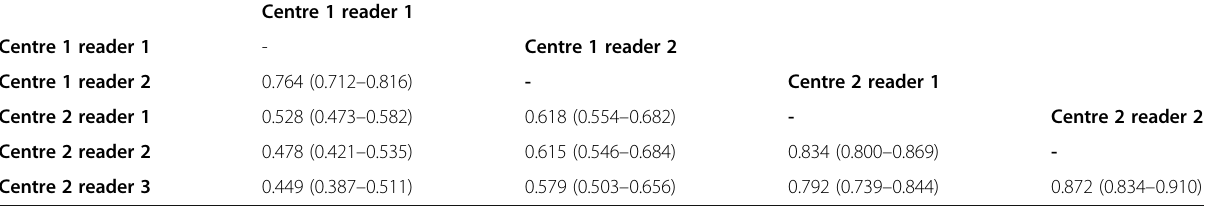
Values in parentheses represent the lower and upper 95% confidence